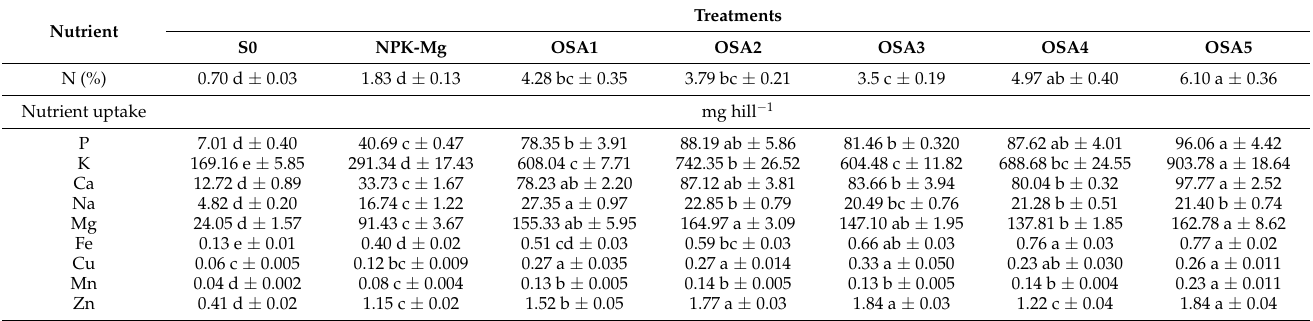
Table 9. Total nitrogen and nutrients uptake by MR219 rice plants as affected by organic soil amendments during the second cropping cycle.